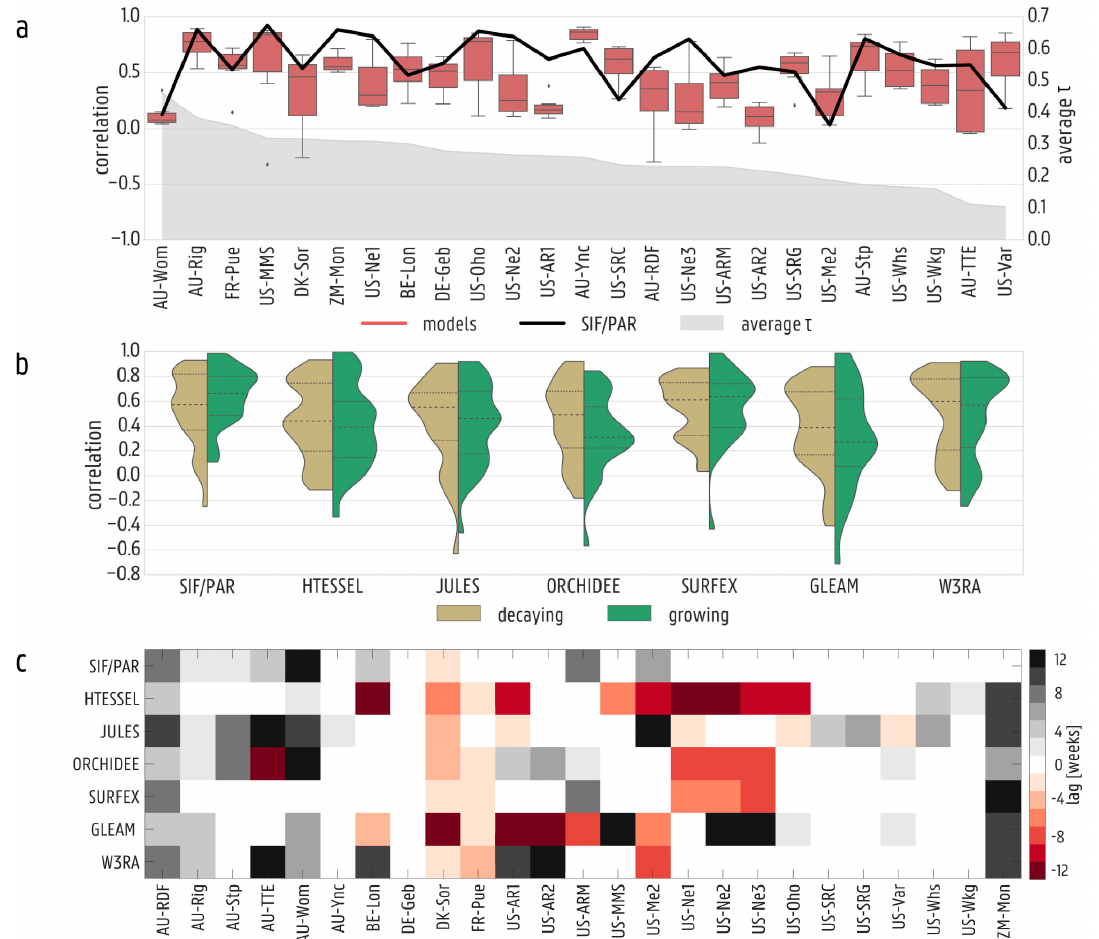
Figure 2. In situ validation. ( a ) Correlations of flux tower sites versus eartH2Observe models (red boxplots) and SIF/PAR (black line) ordered by fraction of bare soil (grey shade, top). ( b ) Results during decaying (gold) and growing (green) periods separately (as defined by average monthly climatologies of tower GPP) for SIF/PAR and each model across flux tower sites. ( c ) Lag at which the cross-correlations for each model and SIF/PAR versus the FLUXNET towers are maximum. Negative values imply an early onset of phenological and/or physiological constraints, while positive implies a delay relative to towers.